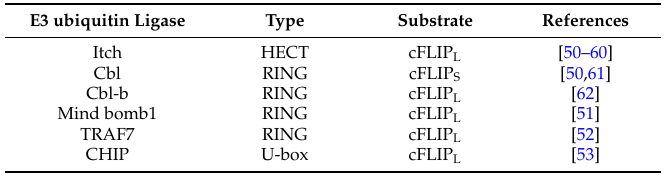
Table 1. Candidate E3 ubiquitin ligases for cFLIP